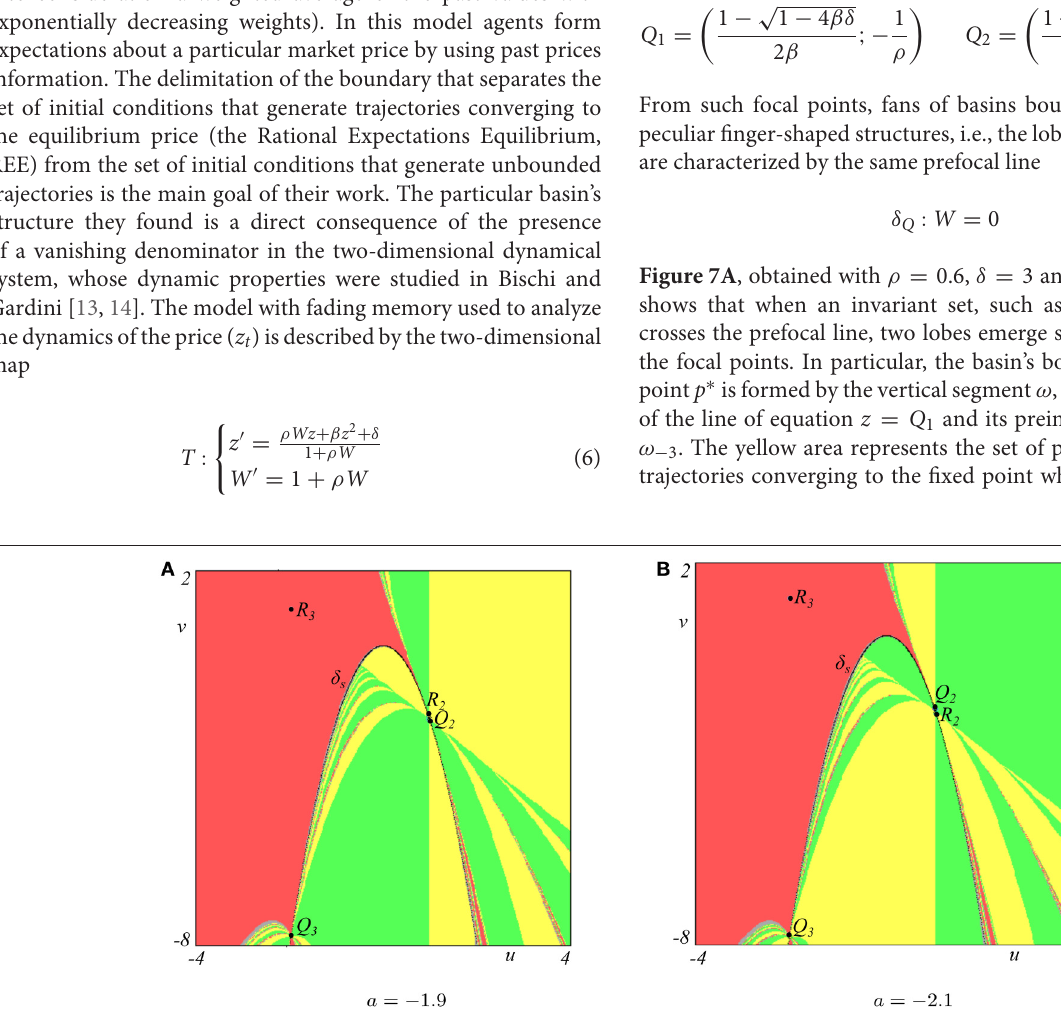
FIGURE 6 | Basins of attraction of the fixed points. (A) a at a = −